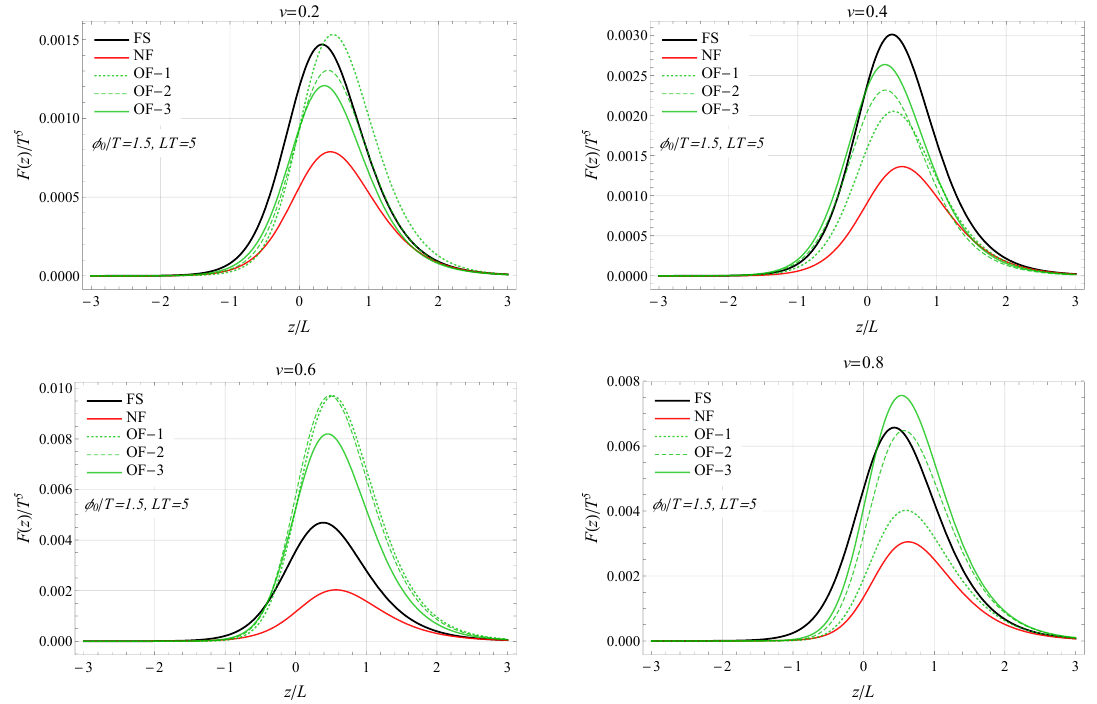
Figure 3 . Friction as a function of the position z when only top annihilation processes are taken into account. The plots correspond to the wall velocities v = 0 . 2 , 0 . 4 , 0 . 6 , 0 . 8